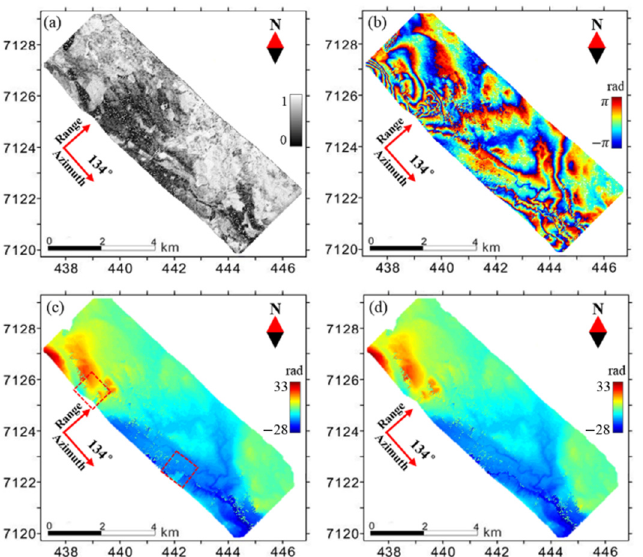
Figure 6. Phase unwrapping of the first sublook coherence: ( a ) coherence map; ( b ) wrapped phase map; ( c ) unwrapped phase map acquired by the MCF method; and ( d ) is the optimized result of ( c ).